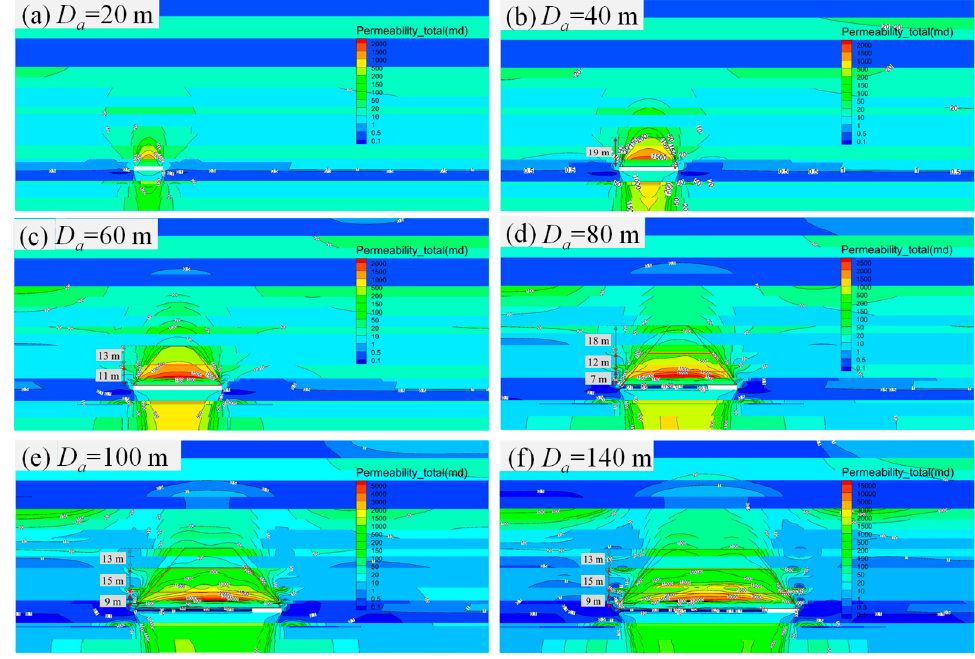
Figure 6. Permeability of the rock mass during the advancement of the working face (the permeability of the black line area is medium, that of the red line is high, and that of the deep red line is ultra-high.).